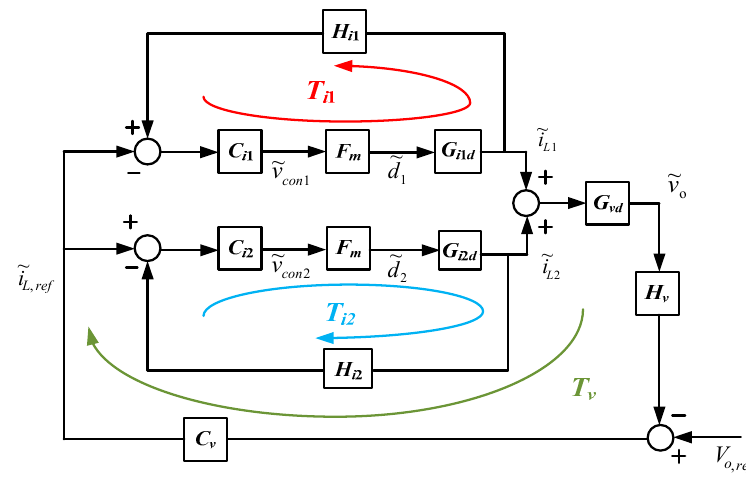
Figure 9. Block diagram for the closed-loop control scheme.